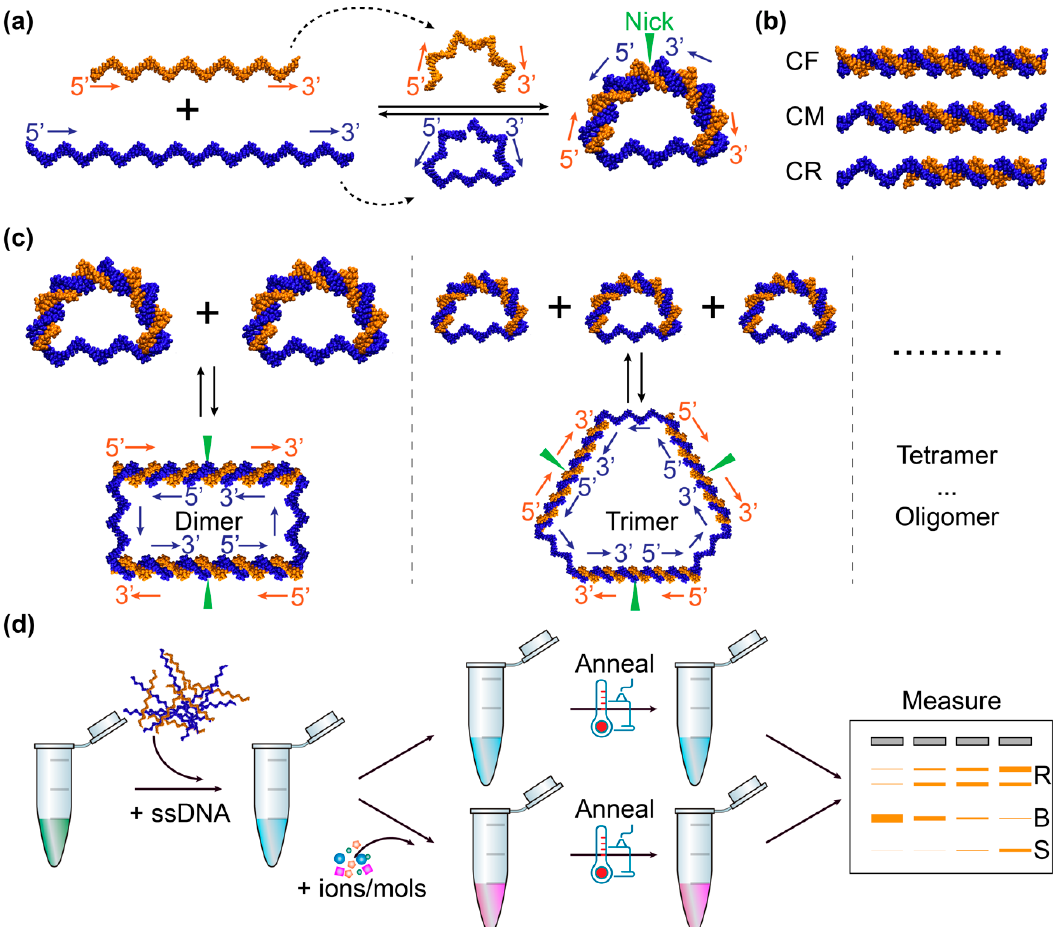
Figure 1. Illustration of sensing amplifiers based on bent DNA bows. ( a ) Construction of DNA bows from synthesized single-stranded DNA. The 5 ′ - and 3 ′ - ends of the DNA strands are indicated, along with arrows from 5 ′ to 3 ′ . The nick in the bent DNA bow is highlighted by the green triangle. ( b ) Linear unbent DNA as negative controls. CF: fully double-stranded DNA; CM: partially double-stranded DNA in the middle; CR: partially double-stranded DNA on the right. ( c ) Relaxation of bending elastic energy in DNA bows by forming dimers, timers, and higher-order oligomers. The 5 ′ - and 3 ′ ends of the DNA strands, the direction from 5 ′ to 3 ′ , and the location of the nicks are highlighted similarly to panel a. ( d ) Sketch of the procedure for detecting DNA interactions with ions and molecules, visualized by gel electrophoresis as an example. R stands for the bands corresponding to the relaxed species (dimers, trimers, etc.). B indicates the band for the bent DNA bows. S represents the band for the unhybridized single-stranded DNA.